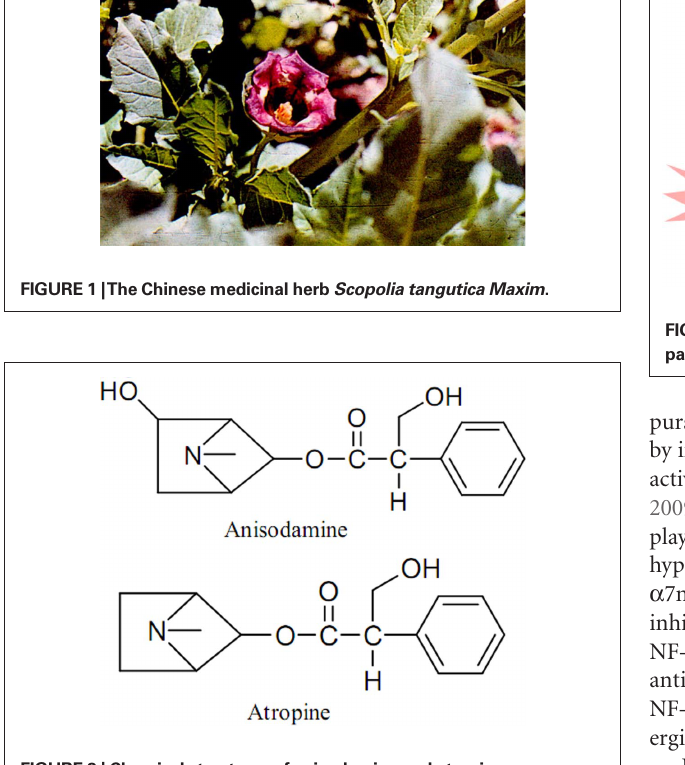
FiguRe 2 | Chemical structures of anisodamine and atropine.